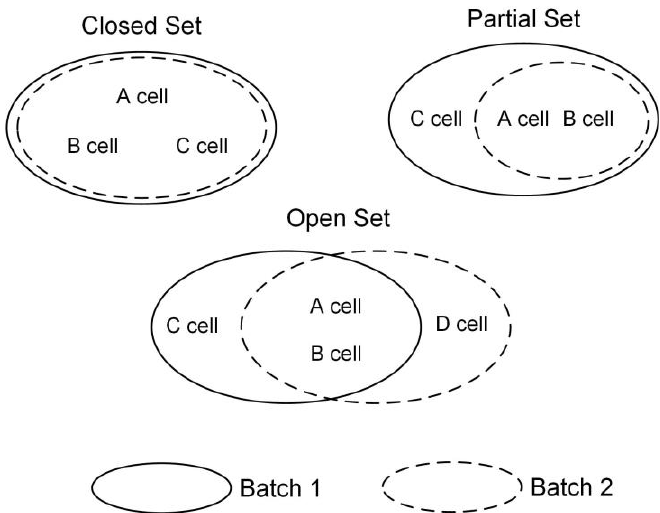
Figure 1. Closed set: each batch has the same type of cells. Partial set: the set of cell types in one batch is a subset of those in another batch. Open set: each batch contains both the same and different types of cells. Only two batches are illustrated; multiple batches can be analogous to the example.